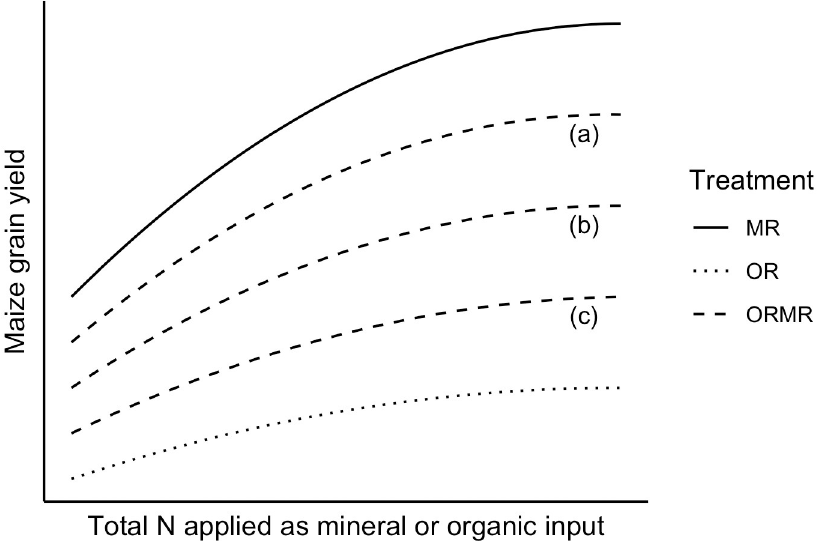
Fig 2. Graph illustrating conceptual response curves of a mineral, organic, and combined input treatment with substitutive design (50% mineral, 50% organic) with interactive effects that can be (a) positive, (b) none existent, and (c)